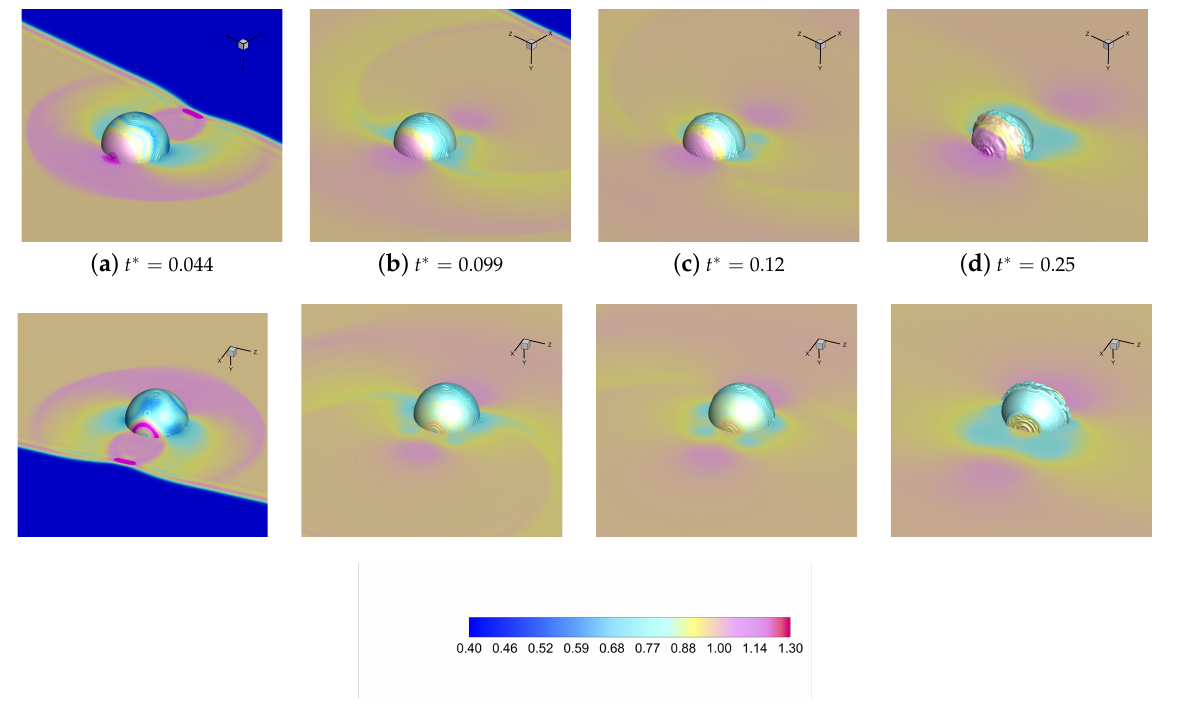
Figure 1. Normalized pressure contours depicted in the midplane y = 0, as well as on the droplet boundary, at four typical time instants with 0.044 ≤ t ∗ ≤ 0.25. Both front ( top ) and back ( bottom ) views are